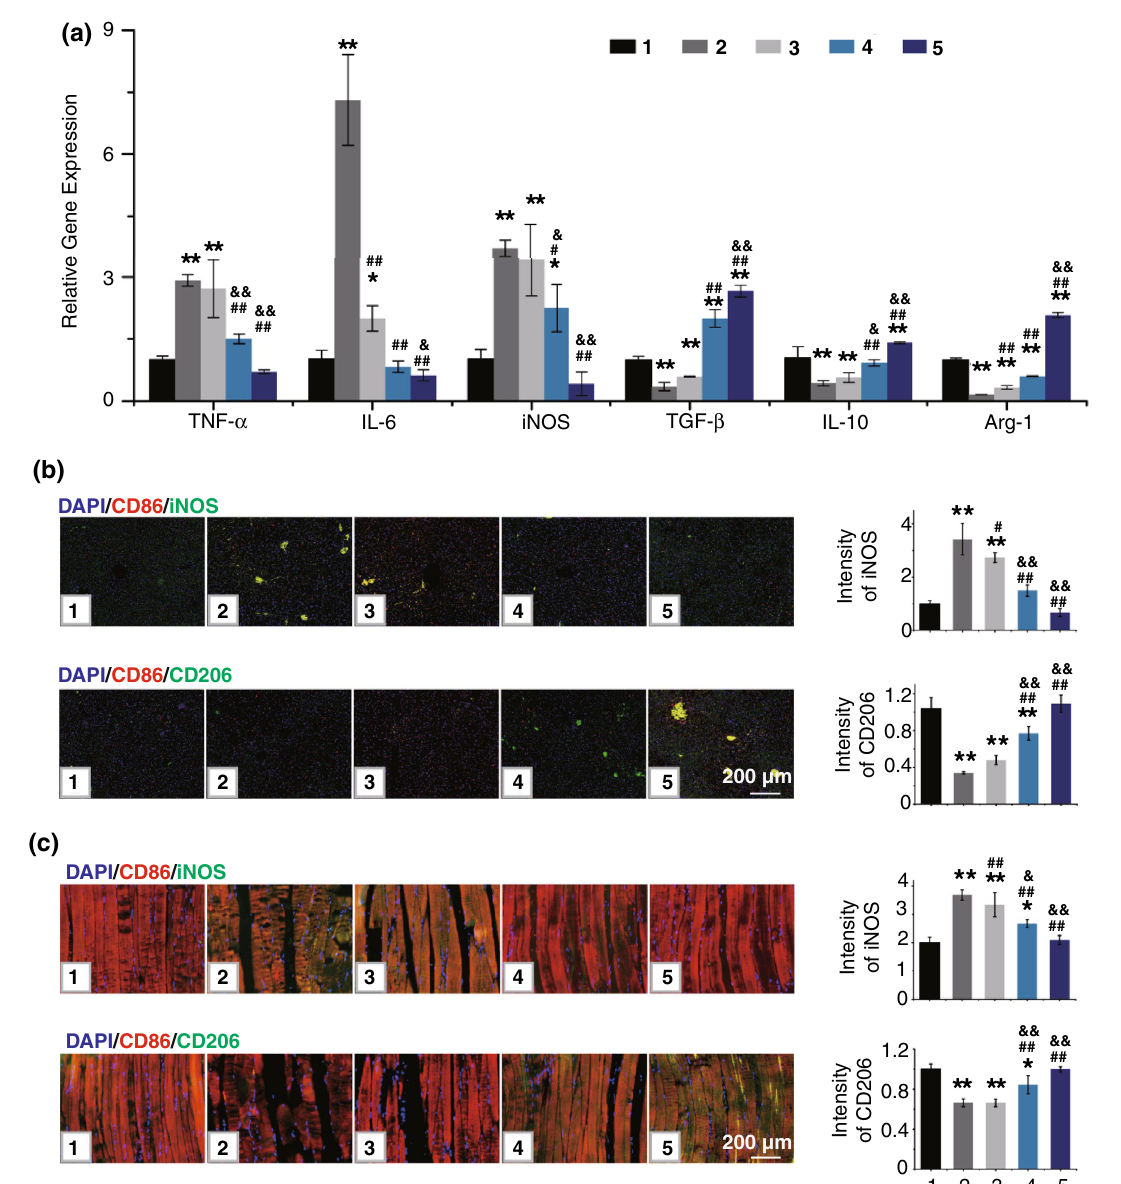
1,Ctrl: 2,HFD; 3,HFD+RSV; 4,HFD+tFNAs; 5,HFD+tFNAs-RSV Fig. 4 tFNAs-RSV ameliorate IR in liver and muscle through macrophages polarization. a Quantitative RT-PCR analysis of the expression of TNF-α , IL-6 , iNOS , TGF-β , IL-10 , and Arg-1 in livers of different mice; b Liver tissue immunofluorescence staining of CD68, iNOS, or CD206, and quantitative analysis of the relative fluorescence intensity of iNOS or CD206; c Skeletal muscle tissue immunofluorescence staining of CD68, iNOS, or CD206, and quantitative analysis of the relative fluorescence intensity of iNOS or CD206. Scale bars: 200 μm. Data were performed using one-way analysis of variance (ANOVA) and presented as mean ± SD ( n ≥ 3). Statistical analysis: * Compare with the control group, * P < 0.05, ** P < 0.01; # Compare with the LPS and IFN-γ group, # P < 0.05, ## P < 0.01; & Compare with the control group, & P < 0.05, && P <